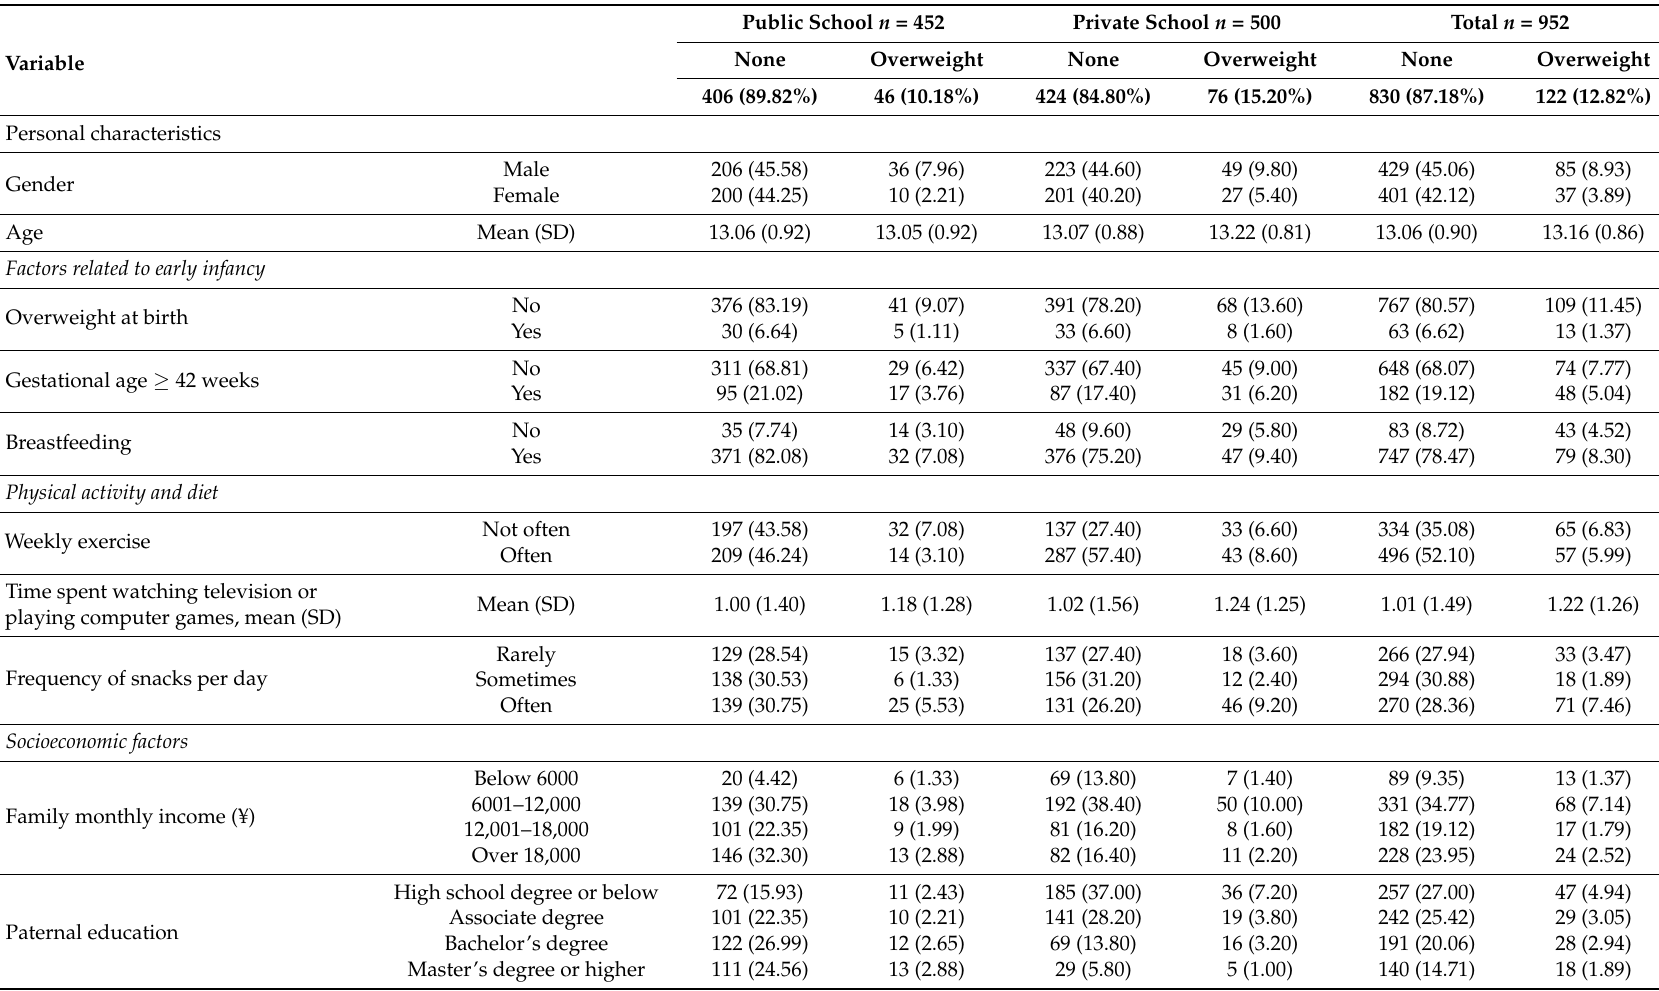
Table 2. Distribution of overweight students and possible determining factors in two types of